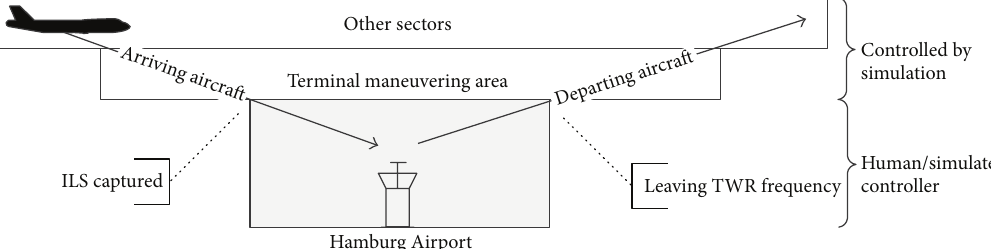
Figure 9: Distribution of air traffic management responsibilities between the air traffic simulation and the human controllers/simulated controller.